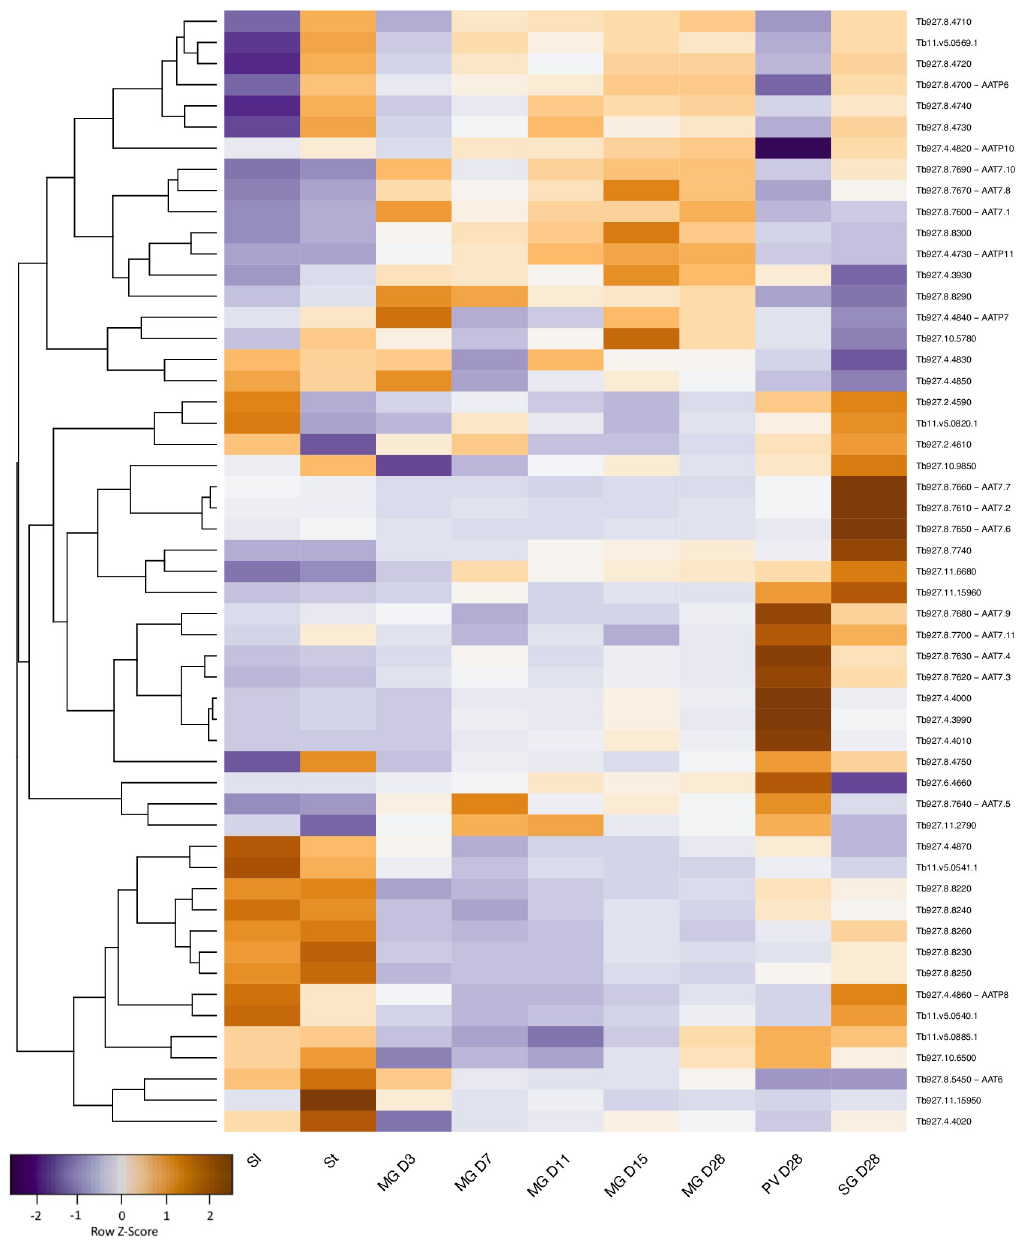
Fig 8. Gene expression heatmap of amino acid transporters. Rows indicate each gene and columns indicate samples. Data were z-score normalised. Colour scale: orange, high expression; blue, low expression. Members of the AAT7-B family are marked by